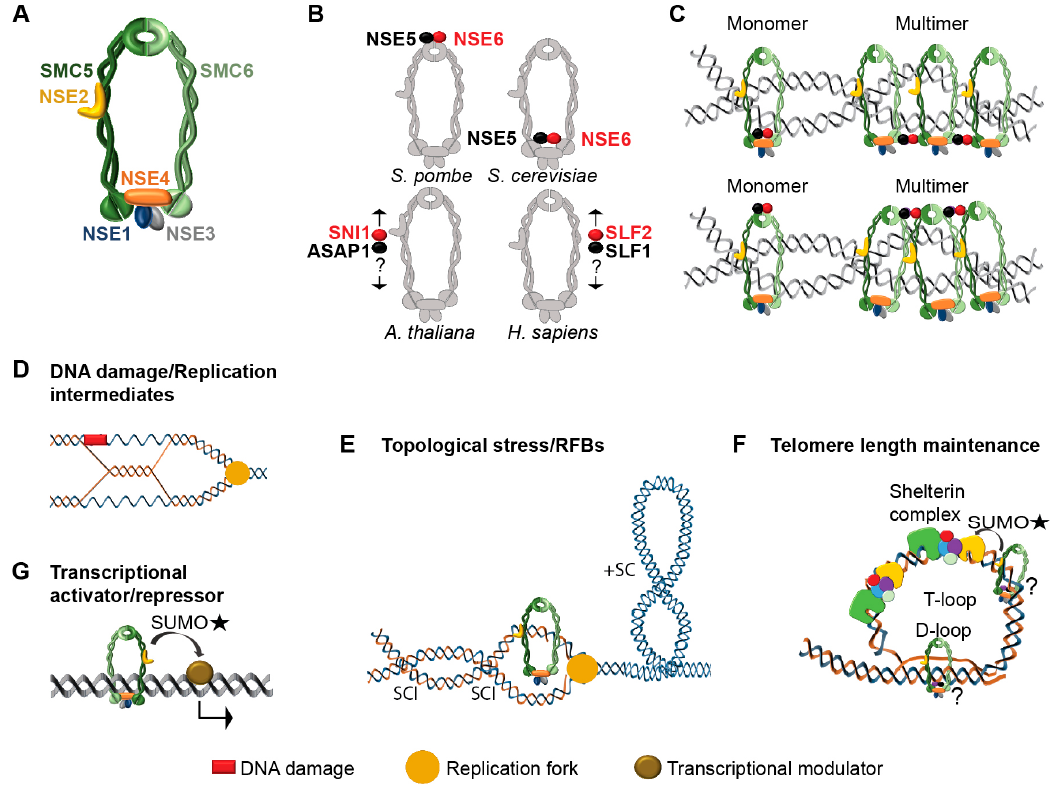
Figure 1. Structural maintenance of chromosomes (SMC) 5/6 complex composition and functions. ( A ) Consensual model of SMC5/6 complex without and ( B ) with species-specific positions of NON-SMC ELEMENT (NSE) 5(-like) and NSE6(-like) subunits in Schizosaccharomyces pombe , Saccharomyces cerevisiae , Arabidopsis thaliana and Homo sapiens . ( C ) Hypothetical function of NSE5-NSE6 dimer in multimerizing SMC5/6 complexes via their heads (top) or hinges (bottom). ( D ) Replication intermediate structure bypassing DNA damage site (red square). ( E ) Topological stress occurring during DNA replication and at replication fork barriers (RFBs) represented by the positive supercoil (+SC) ahead of the replication fork and sister chromatid intertwining (SCIs) between the nascent chromatids. ( F ) Role of SMC5/6 complex in telomere length maintenance. ( G ) Speculative model for SUMOylation of transcriptional modulations by SMC5/6 complex. Note that the position of SMC5/6 complex in images ( C ), ( E ), ( F ) and ( G ) is only speculative.